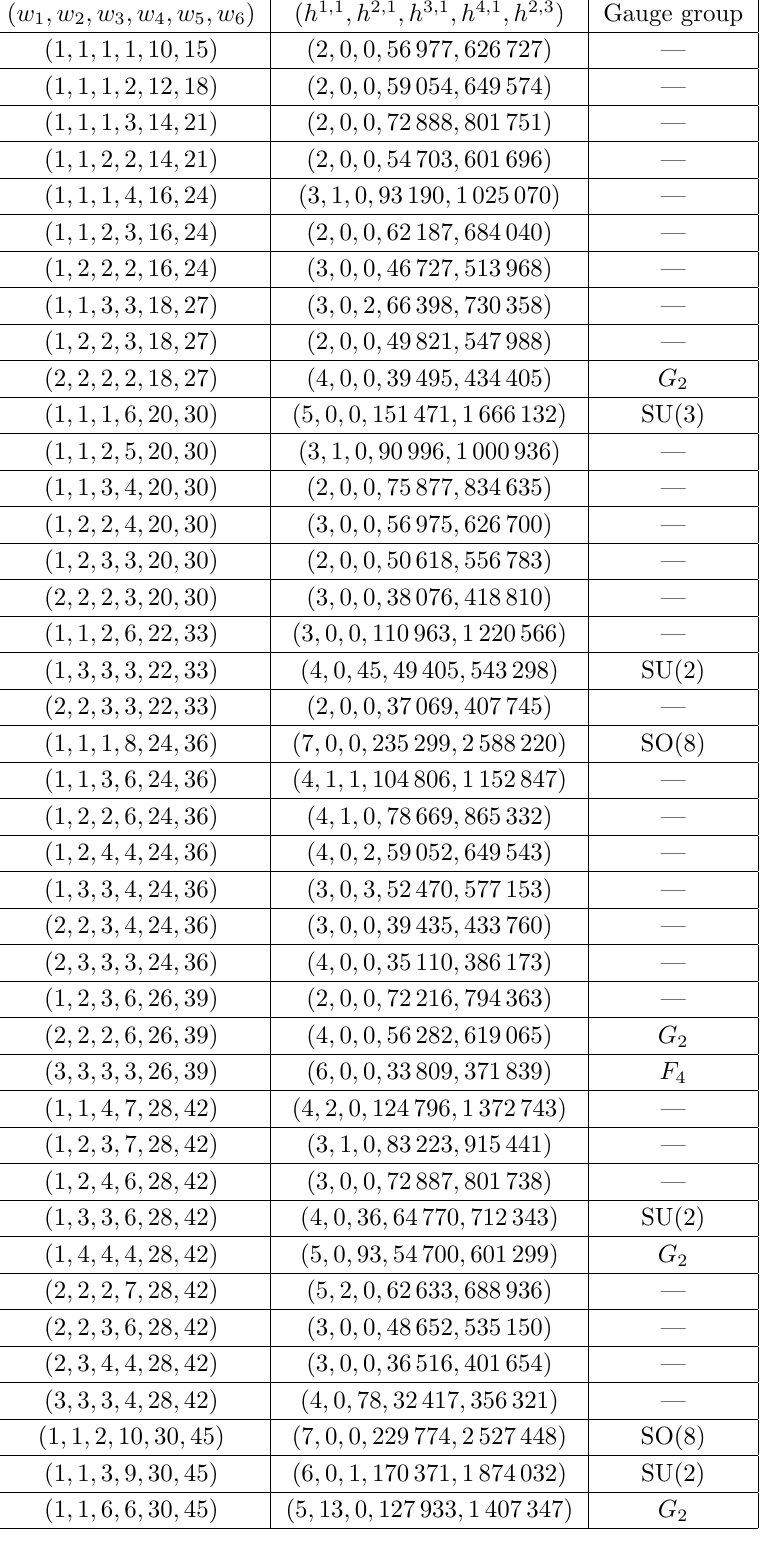
Table 9 . A list of elliptic CY5 hypersurfaces in weighted projective spaces P 1 ,w 1 ,w 2 ,w 3 ,w 4 ,w 5 ,w 6